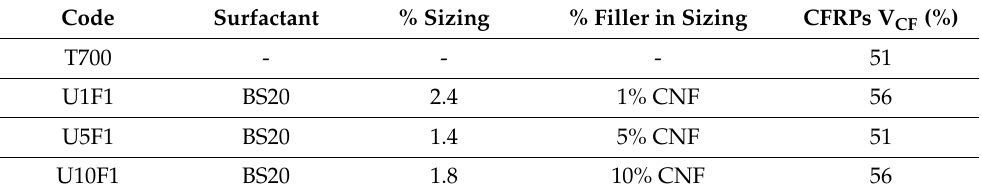
Table 1. Detail of sizing of T700 CFs with CNFs and CF volume fraction of the respective CFRPs.